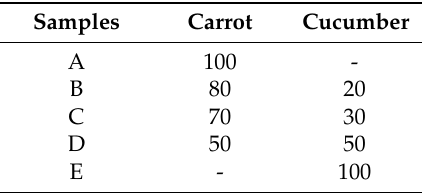
Table 1. Juice mixing ratio